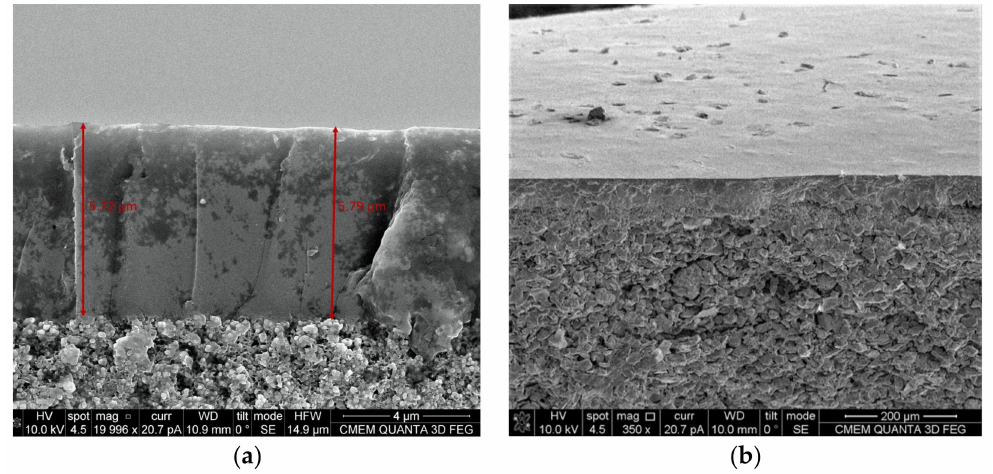
Figure 5. SEM images of R80 CMSMs (Carbon Molecular Sieve Membranes) magnified 20,000 ( a ) and 350 times ( b ).